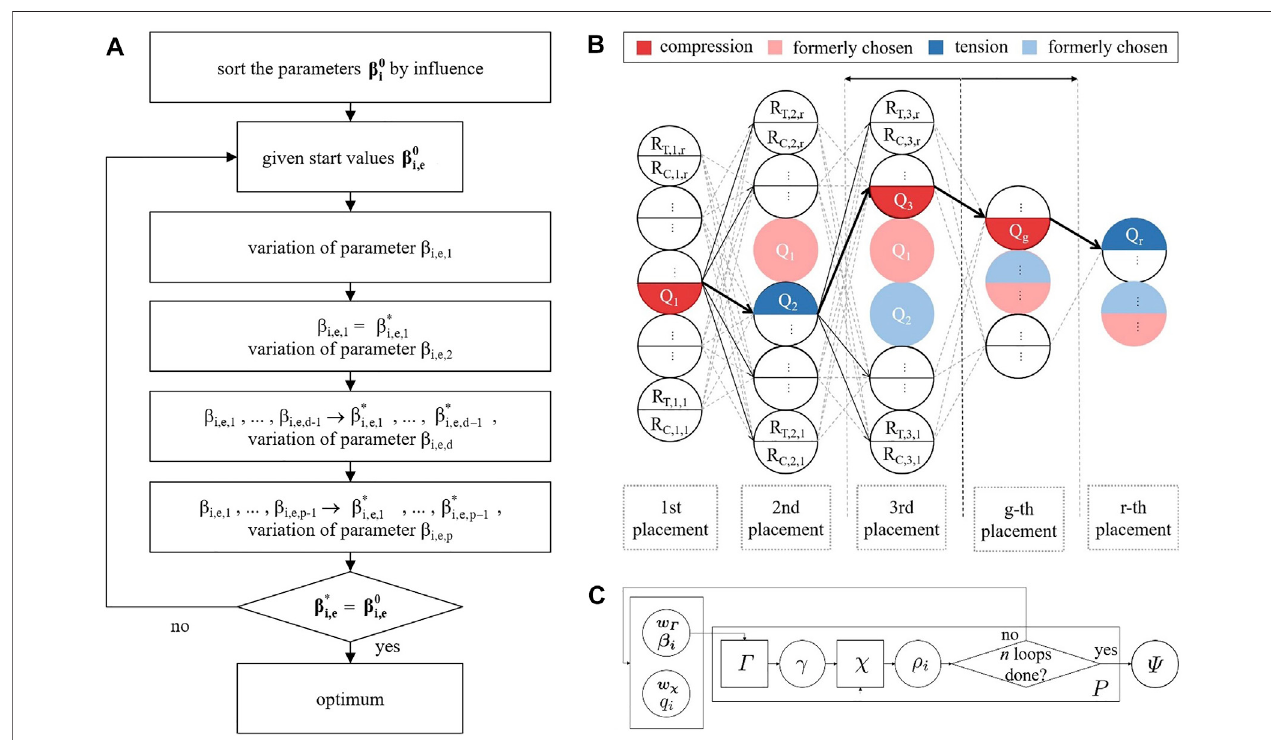
FIGURE1| Flowchartsof (A) operator Γ — structuraloptimization, (B) operator χ — choiceofactuators,and (C) entirehierarchicalmethod — successiveexecutionof operator χ after operator Γ .